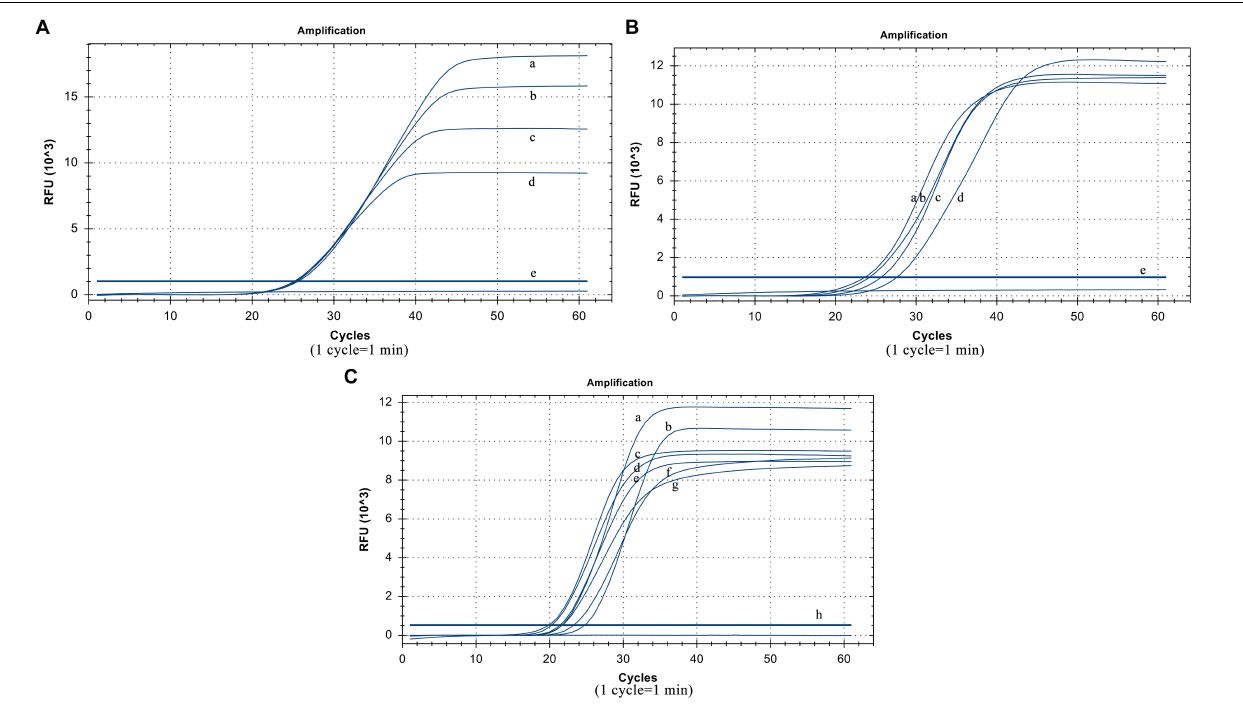
FIGURE 3 | Optimized results. (A) Usage of the loop primer probe. (a) 20 pmol, (b) 15 pmol, (c) 10 pmol, (d) 5 poml, (e) Negative control. (B) Usage of the loop primer. (a) 15 pmol, (b) 10 pmol, (c) 20 pmol, (d) 5 pmol, (e) Negative control. (C) Usage of Rnase H2 enzyme. (a)0.06 U/ µ L, (b) 0.02 U/ µ L, (c) 0.12 U/ µ L, (d) 0.1 U/ µ L, (e) 0.14 U/ µ L, (f) 0.04 U/ µ L, (g) 0.08 U/ µ L (h) Negative